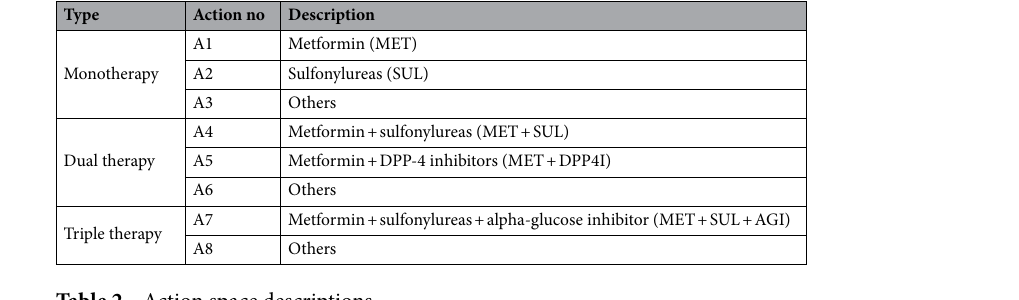
Table 2. Action space